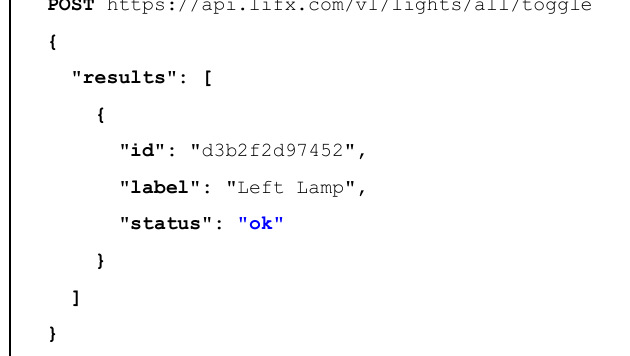
Fig. 4. The LIFX API response in JSON for the “toggle lights” function. The response does not tell API users if the light ended up on or off after the operation (Link: https://api.developer.lifx.com/docs/toggle-power, visited November 4 th